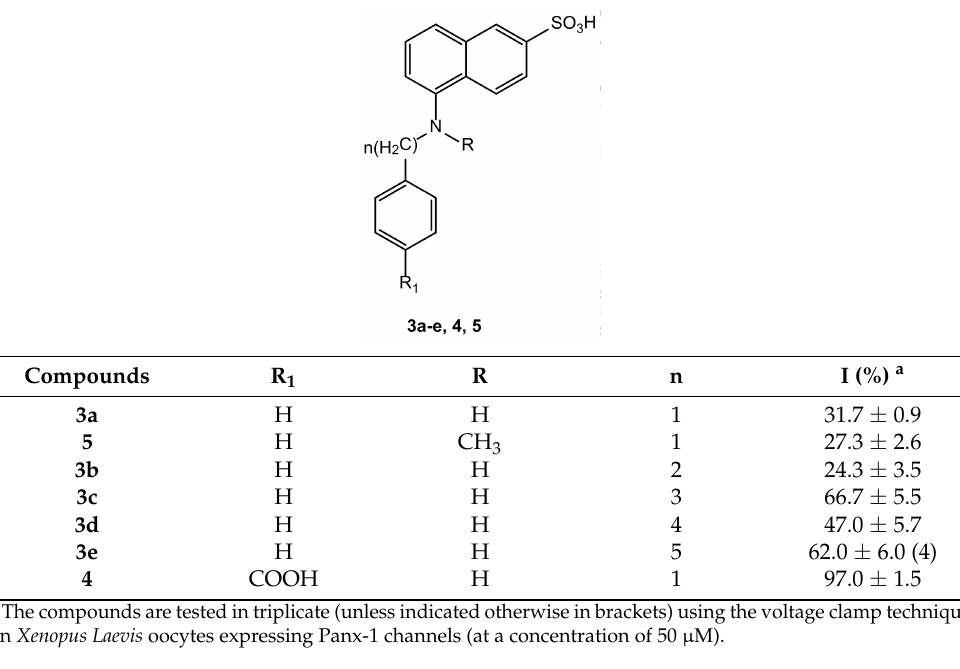
Table 1. Inhibition (%) values of compounds 3a – e , 4 and 5 .